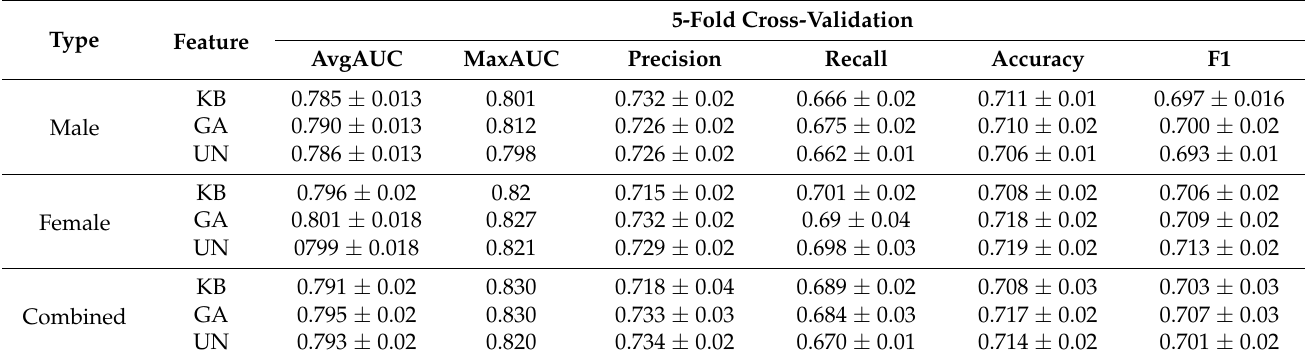
Table 1. Performance evaluation of S-palmitoylation prediction from 5-fold cross-validation using three different sets of features on three data types, Male, Female, and Combined.